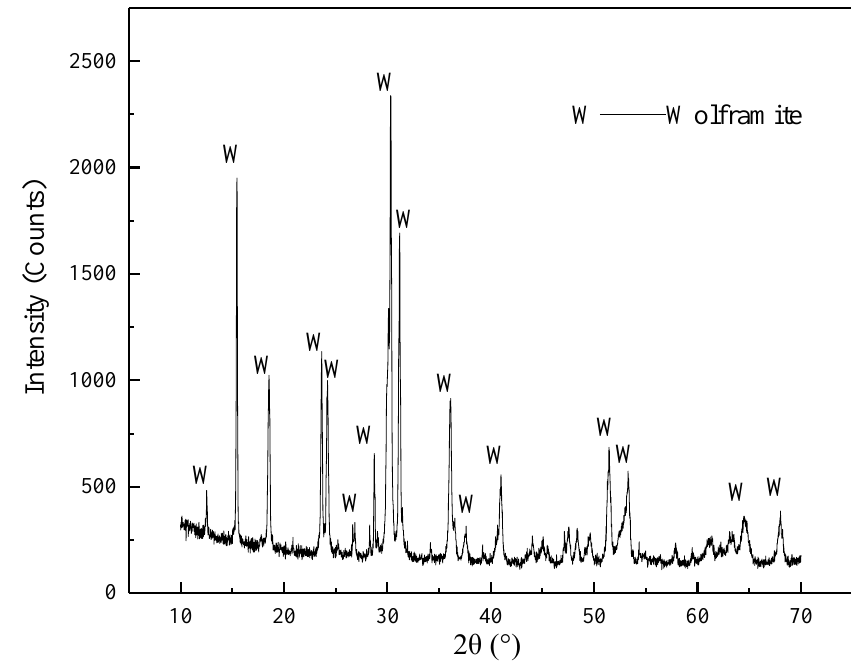
Figure 1. XRD diffraction pattern of wolframite single mineral.